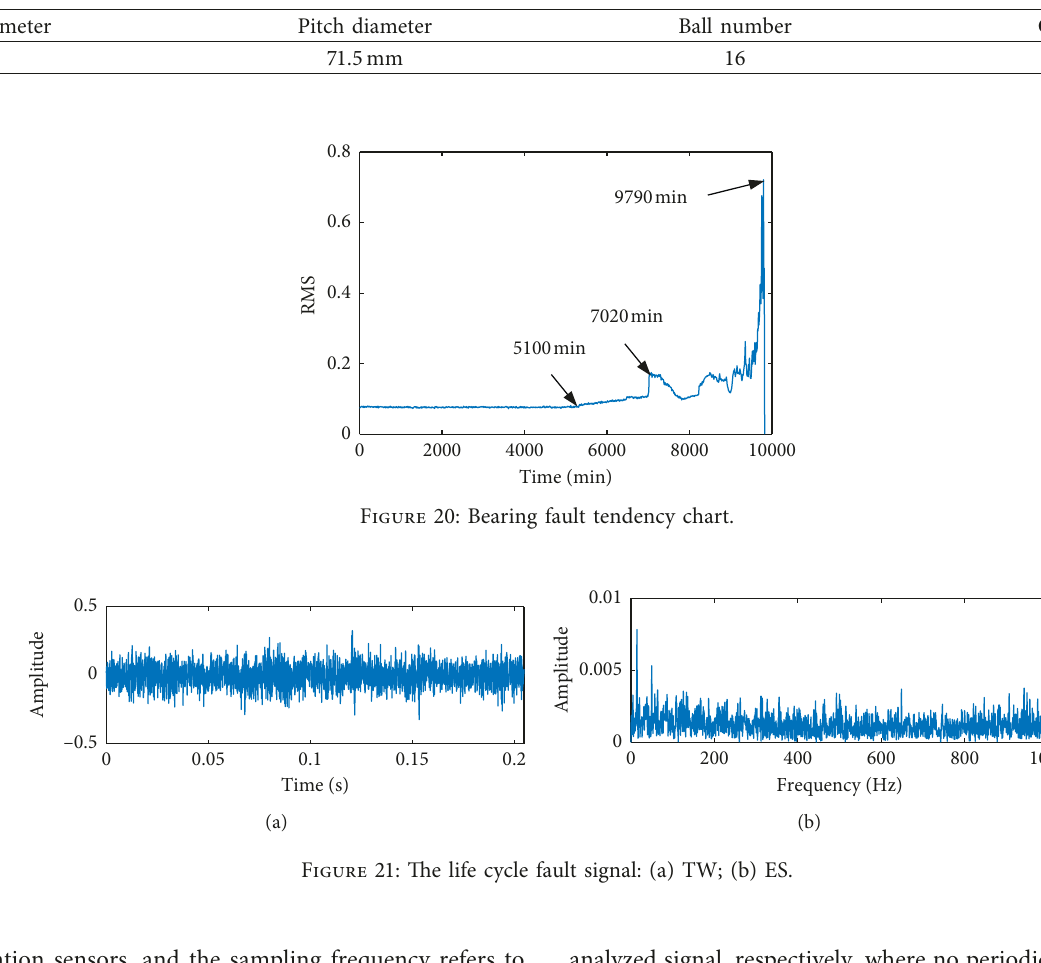
Table 3: Bearing structure factor of ZA2115.